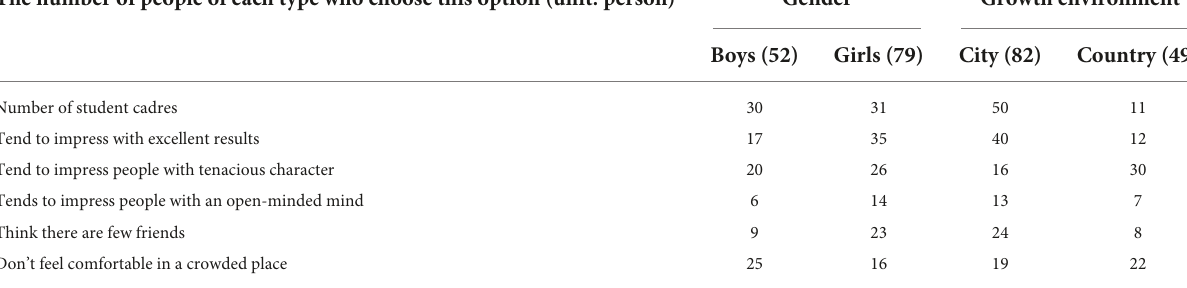
Table 13 . In general, college students from divorced families choose far more people with changeable emotions than those who are depressed and stable. Among the 72 people who responded that they are often moody, 54 are girls, while